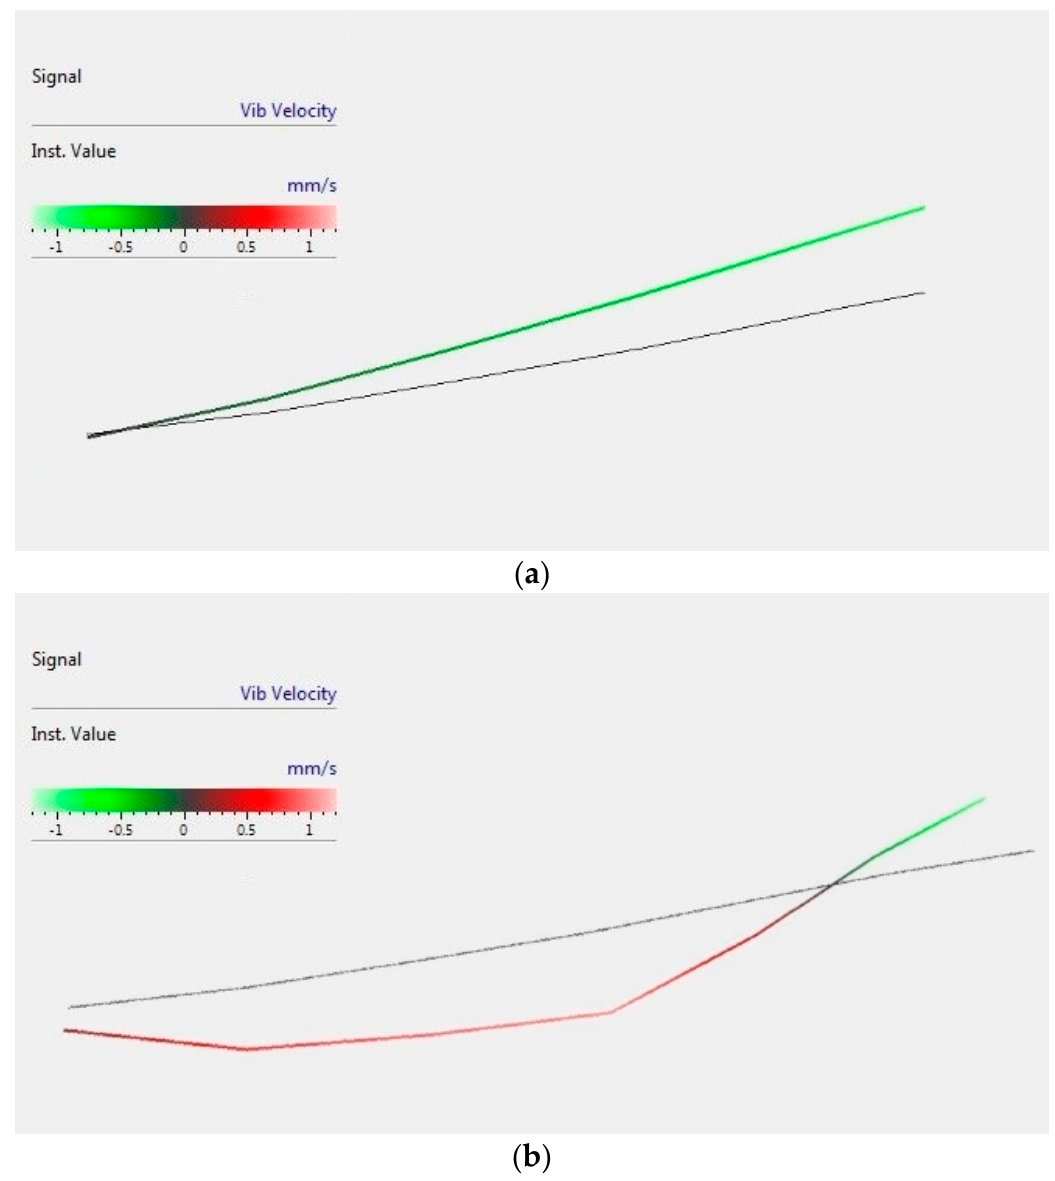
Figure 7. ( a ) First and ( b ) second bending mode shapes obtained with the laser